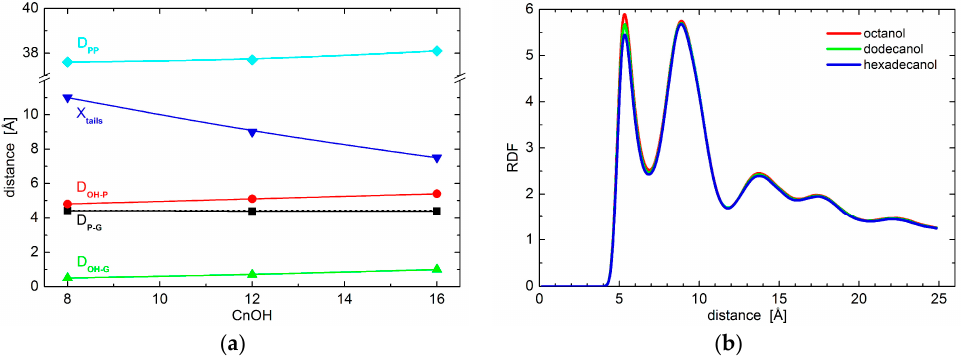
Figure 2. ( a ) The relative distances between DOPC phosphate and/or glycerol groups and OH group and/or tails of alcohols with different length as obtained from coarse-grained molecular dynamics simulations. The black points depict the phosphate-glycerol distance (note the broken line corresponding to neat DOPC bilayers that overlaps with data for alcohol loaded bilayers), while red and green points show the OH-phosphate and OH-glycerol distances, respectively. The positions of alcohol tail centers are shown by blue points. The cyan color depicts phosphate-to-phosphate distance. The solid lines serve as guides to the eye; and, ( b ) Two-dimensional radial distribution function (RDF) for the phosphate groups within one leaflet of bilayers loaded with various alcohols.